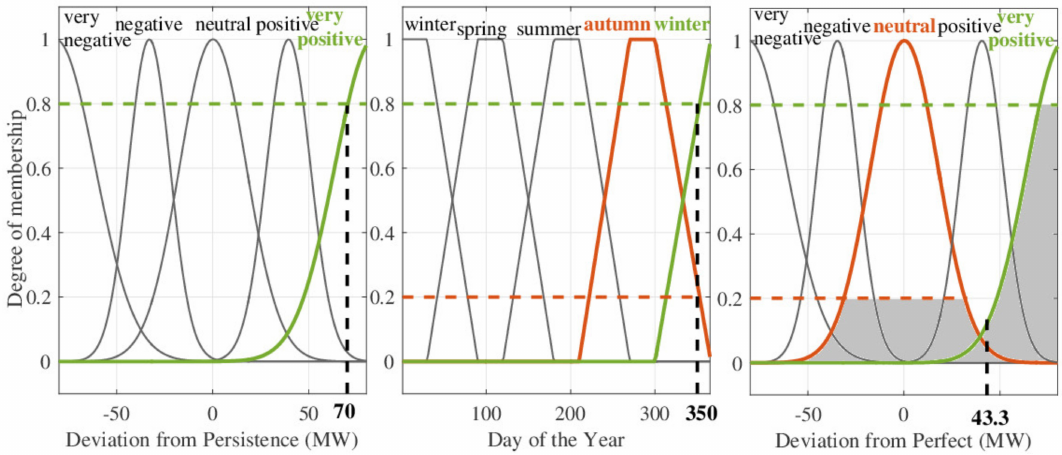
Figure 8. Fuzzy classification and inference procedure for the given numerical example.